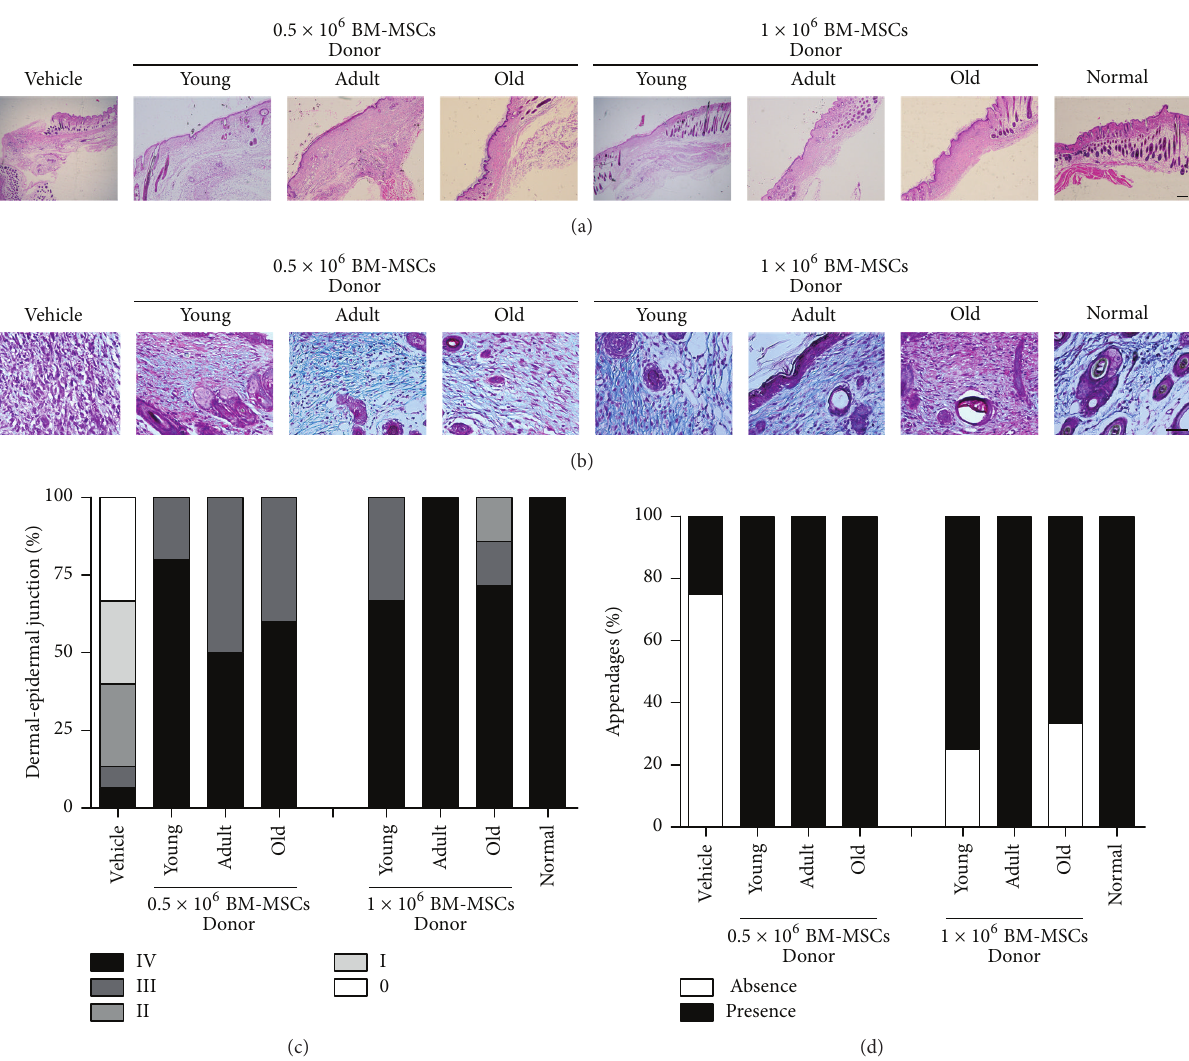
Figure 2: Syngeneic BM-MSCs led to the recuperation of quality regenerated skin. Histological section images 12 days after treatment. (a) Haematoxylin-eosinstainthatrepresentsthedermoepidermaljunction.Scalebar100 𝜇 m.(b)Masson’strichromestainthatshowsappendage- like structure in the dermis. Scale bar 50 𝜇 m. Frequency (%) of animals with (c) different histological scores of dermoepidermal junction